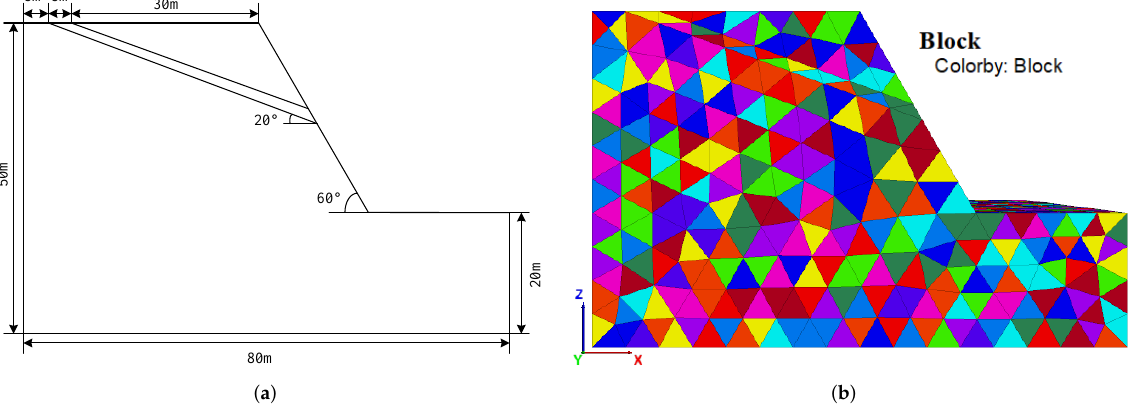
Figure 5. The sketch and computational model of a simplified slope. ( a ) The sketch, ( b ) the computa- tional